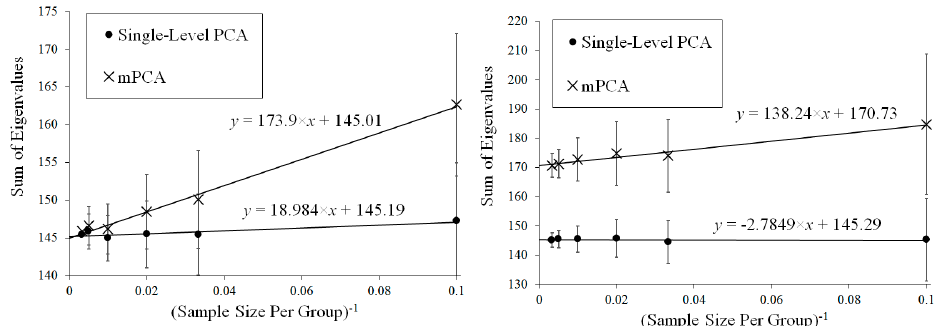
Figure 10. Extrapolation of the mean (over all MC simulations) sum of all eigenvalues for PCA and mPCA in the limit sample size per group 𝑛 (cid:3039) → ∞ for Experiments 4 ( left ) and 5 ( right ). The values for mPCA again scale approximately linearly with 𝑛 (cid:3039)(cid:2879)(cid:2869) . Results of single-level PCA are approximately “flat” with respect to 𝑛 (cid:3039)(cid:2879)(cid:2869) . (Standard errors are shown by the error bars.)